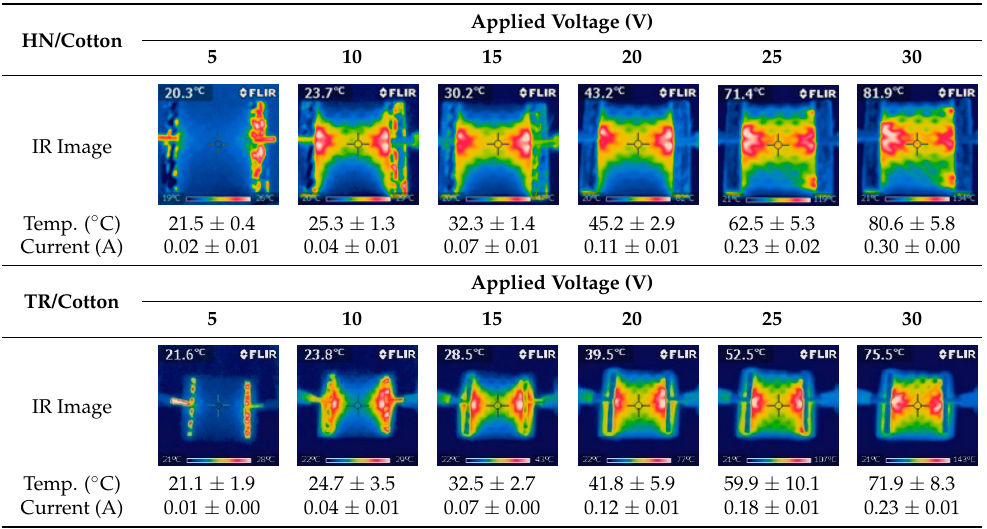
Table 5. IR images of CFDM 3D printed graphene/PLA auxetic pattern/cotton composite fabric by honeycomb and truss pattern.